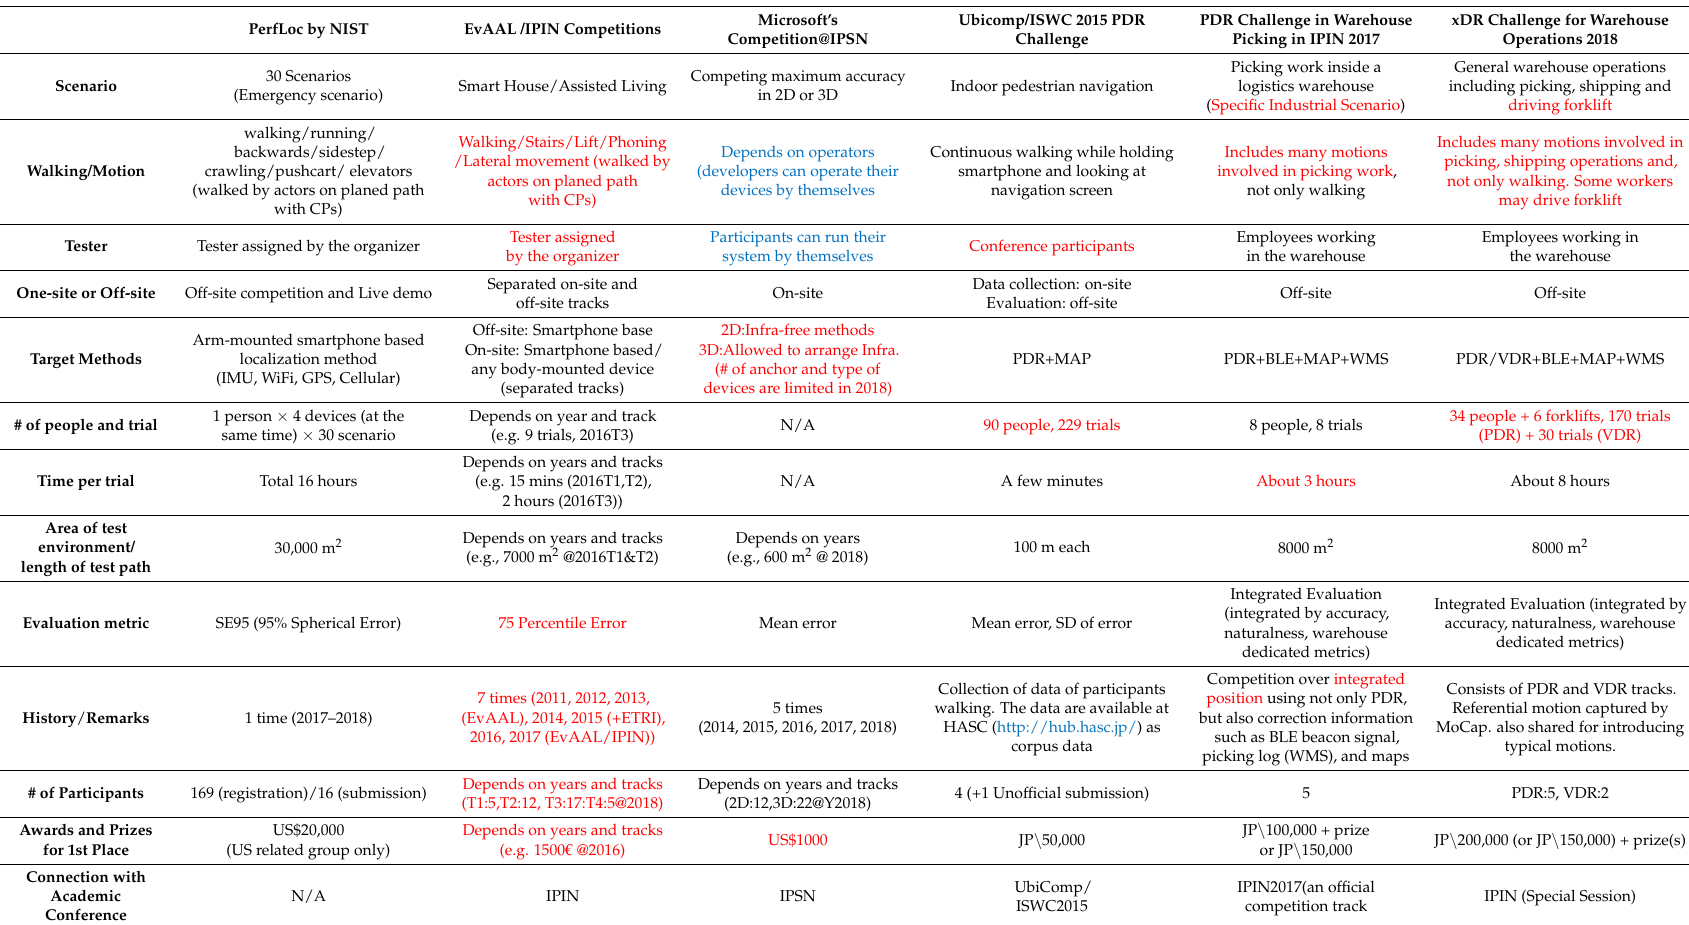
Table 1. Brief survey of existing indoor localization